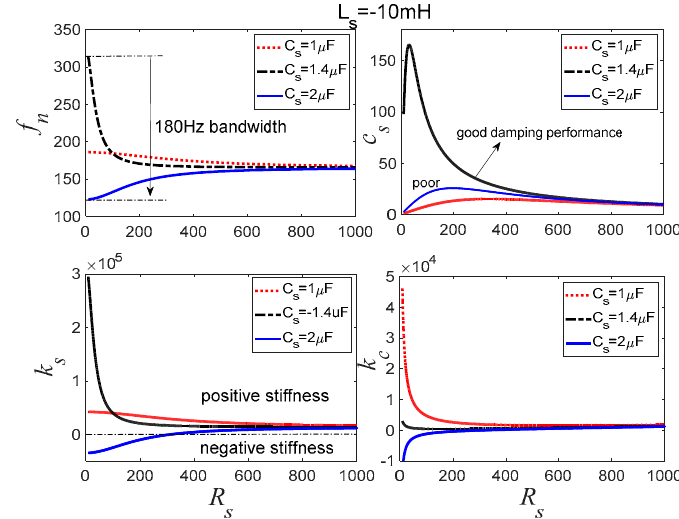
Figure 7 . Controlled stiffness analysis for the negative capacitance in parallel with R s shunt.